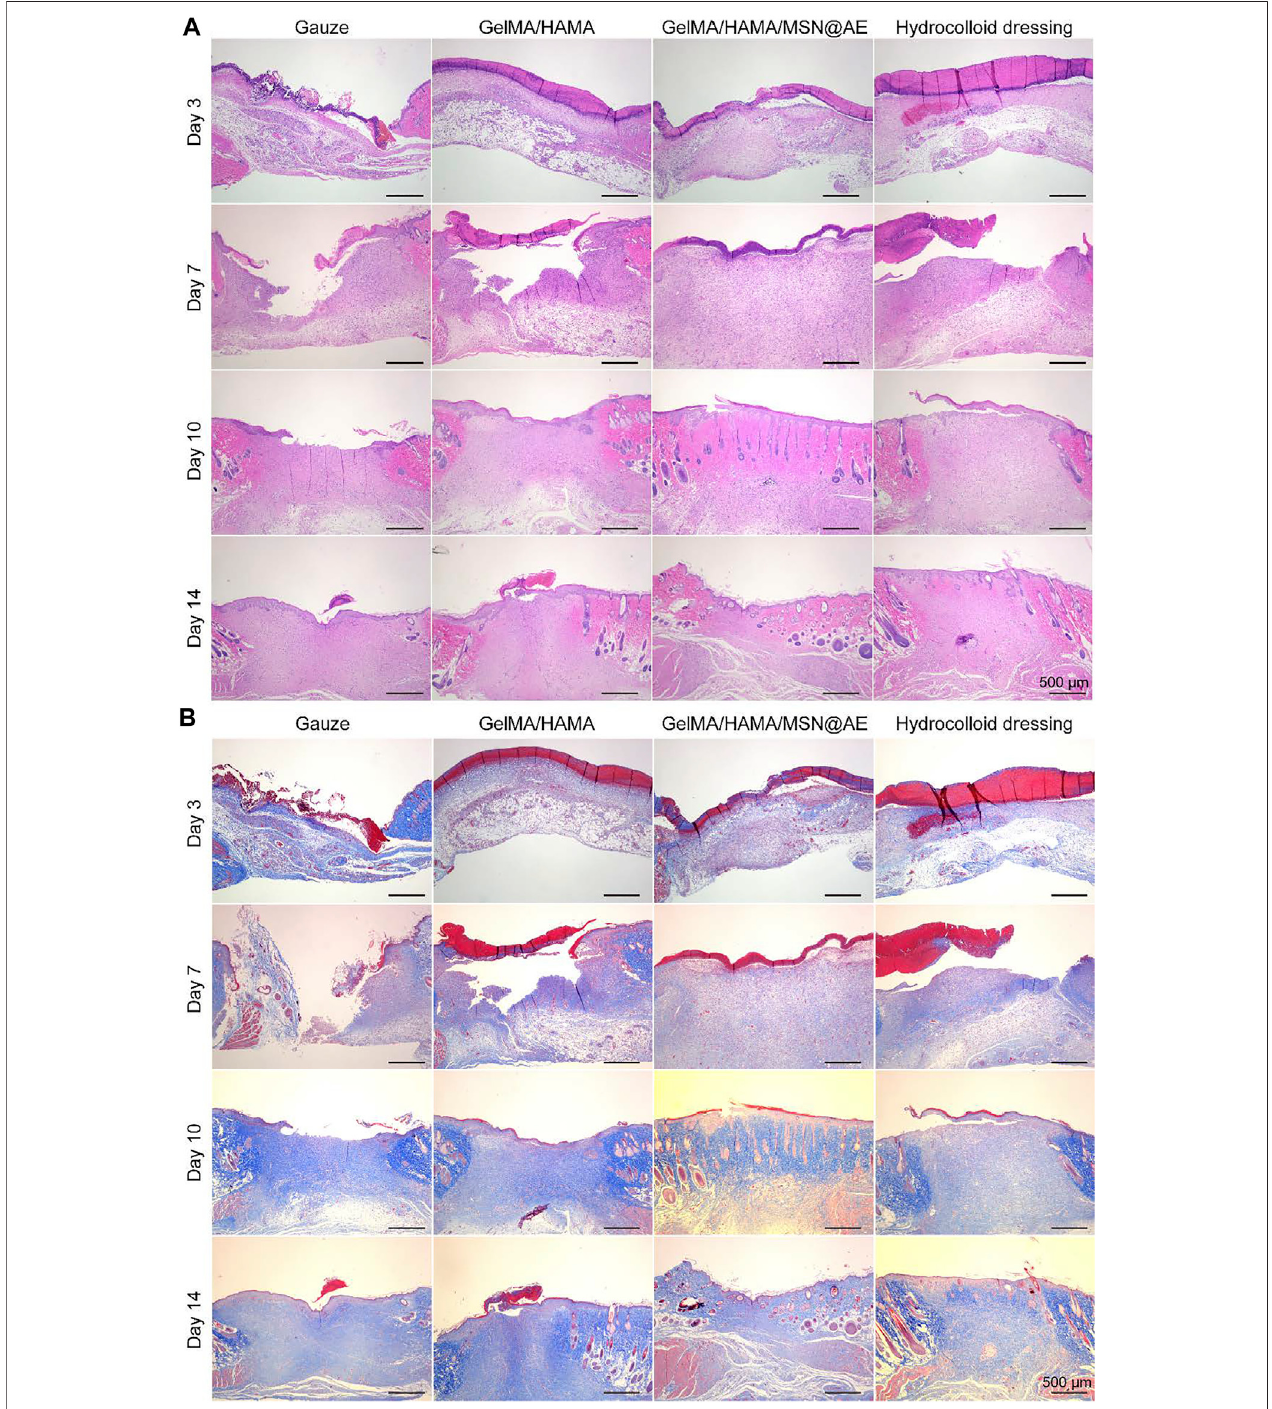
FIGURE 6 | (A) Representative H&E staining images acquired on days 3, 7, 10, and 14 after surgery. (B) Representative Masson ’ s trichrome staining images acquired on days 3, 7, 10, and 14 after surgery.